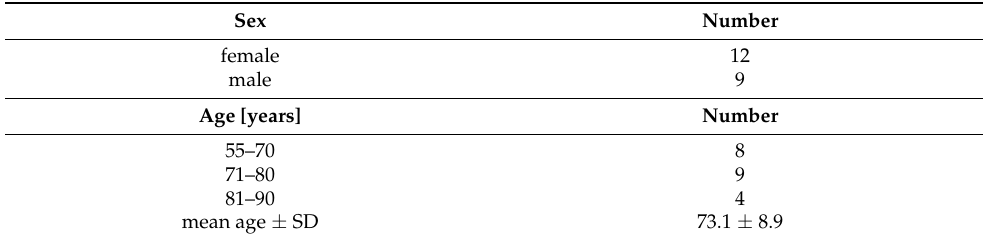
Table 2. Glaucoma patients interviewed, according to sex and